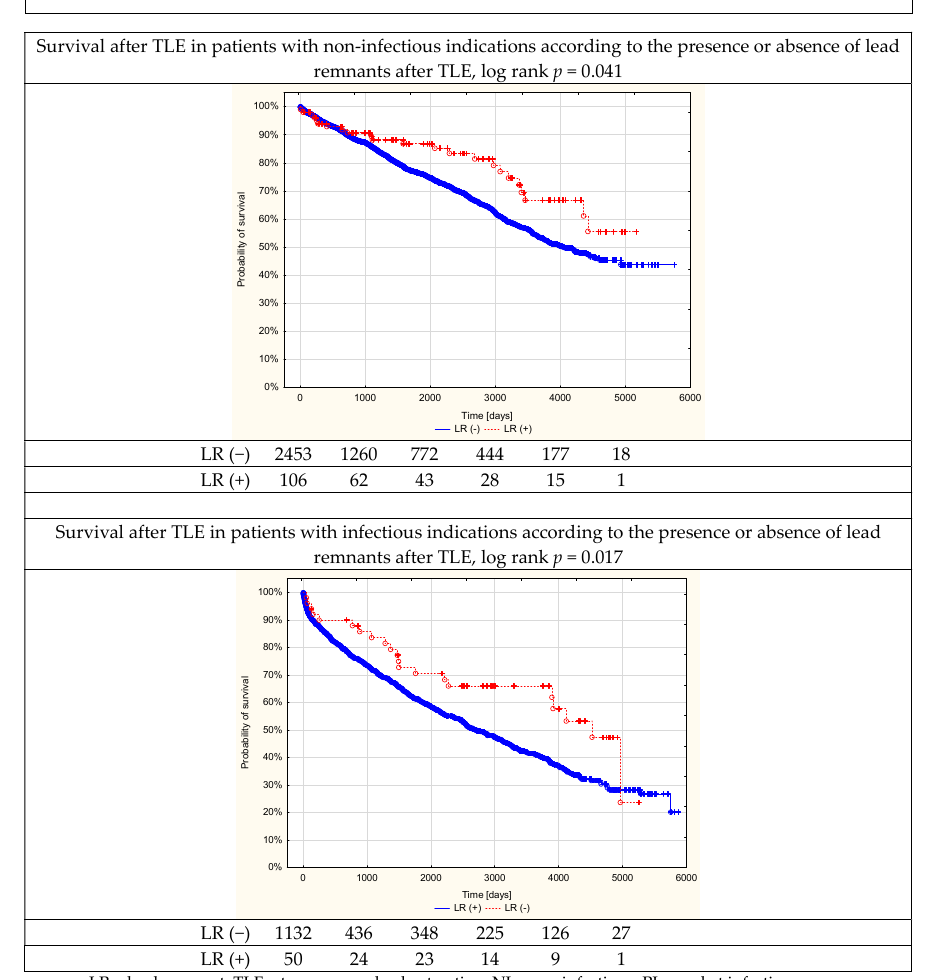
Figure 1. Survival after TLE according to the presence or absence of lead remnants and infectious (pocket infection or lead-related infective endocarditis) or non-infectious indications. A p -value less than 0.05 was considered significant. Statistical analysis was performed using the Statistica 13.3 (TIBCO Software Inc., Palo Alto, CA, USA).